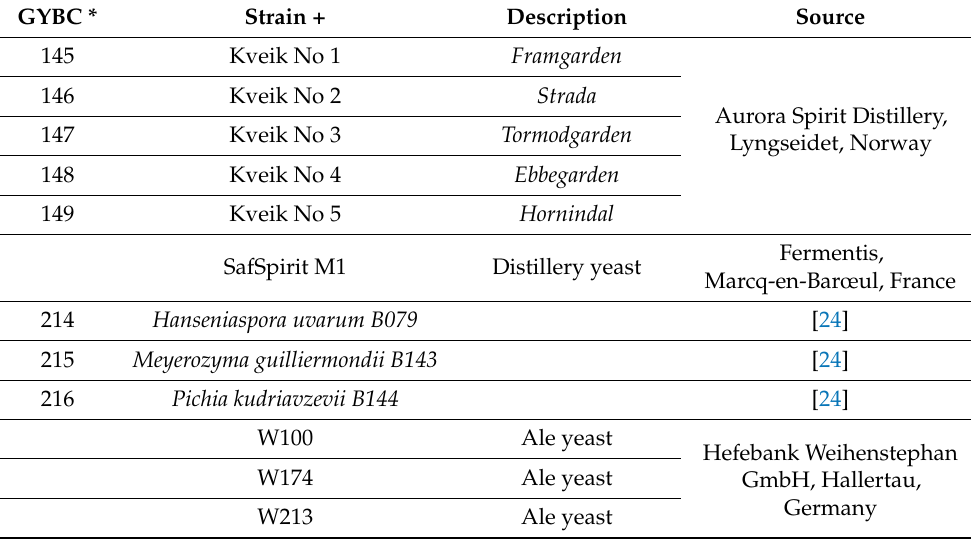
Table 2. Strains used in this study. GYBC * Strain + Description